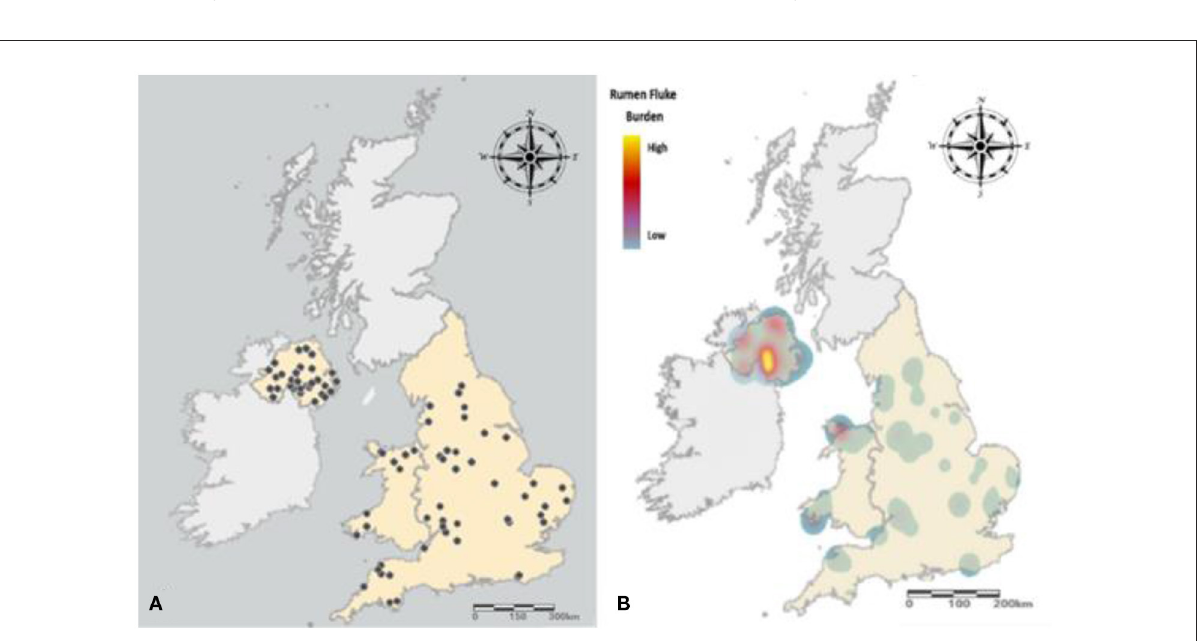
carcass weight and sex category, it was revealed that there was no significant difference between the market demand for the